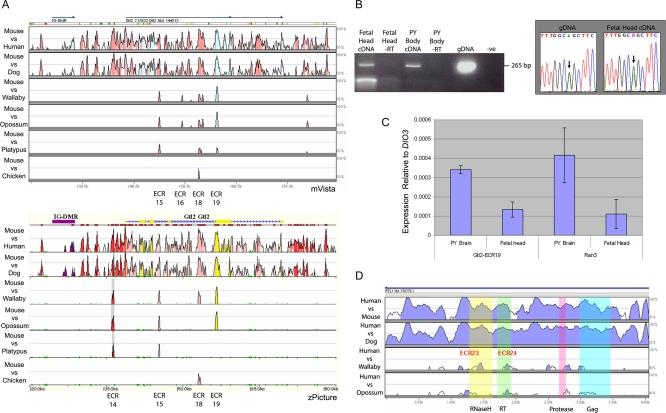
Assessment of Noncoding RNA Transcription(A) Identification of ECRs in the Gtl2 region in noneutherians. mLAGAN and zPicture alignments of mouse Gtl2 with human, dog, wallaby, opossum, platypus, and chicken are shown. Four intronic ECRs are identified and one (ECR19) aligns within exon 5 of NM_144513. ECR14 is inverted in the eutherians and was only identified using the zPicture alignment. Weak expression was identified for ECRs14, 15, 18 and 19. RT-PCR for ECR19 in fetal head and pouch young body is shown.(B) Weak expression from ECR19 in tammar wallaby fetal head and pouch young. An A/G SNP was identified in ECR19 and biallelic expression was observed.(C) The expression ratio of ECR19 and Random Primer set 3 relative to DIO3 in fetal head and pouch young brain as calculated by quantative RT-PCR.(D) A region orthologous to the retrotransposon-derived gene Rtl1 was identified in marsupials. The mLAGAN algorithm was used to align human RTL1 with mouse, dog, wallaby, and opossum. Regions with homology of >55% over 80 bp are shown in blue. Regions of human RTL1 with homology to the Sushi-ichi domains are highlighted. Homology between the eutherian and marsupial regions indicates that RTL1 inserted into the region before the divergence of eutherians and metatherians.